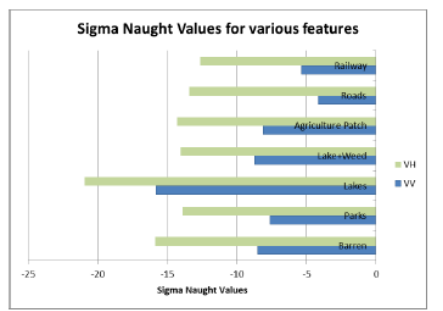
Figure 6: Sigma Naught values of various features